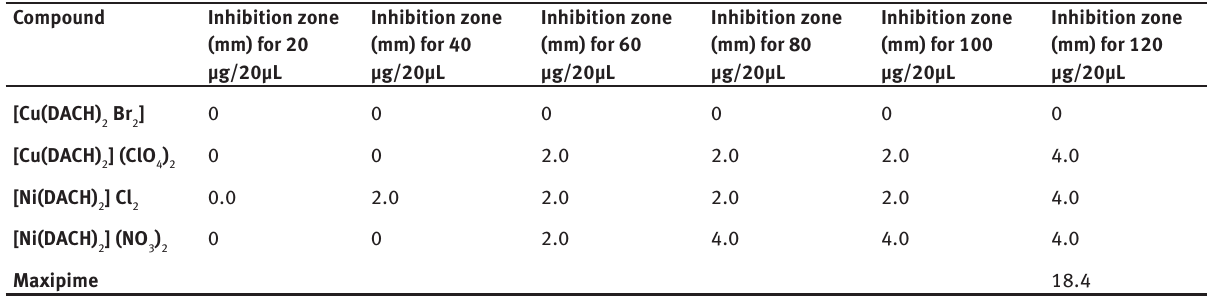
Table 7: Results of Antibacterial activity of the coordination complexes of DACH against Klesbiella pneumonae . Compound